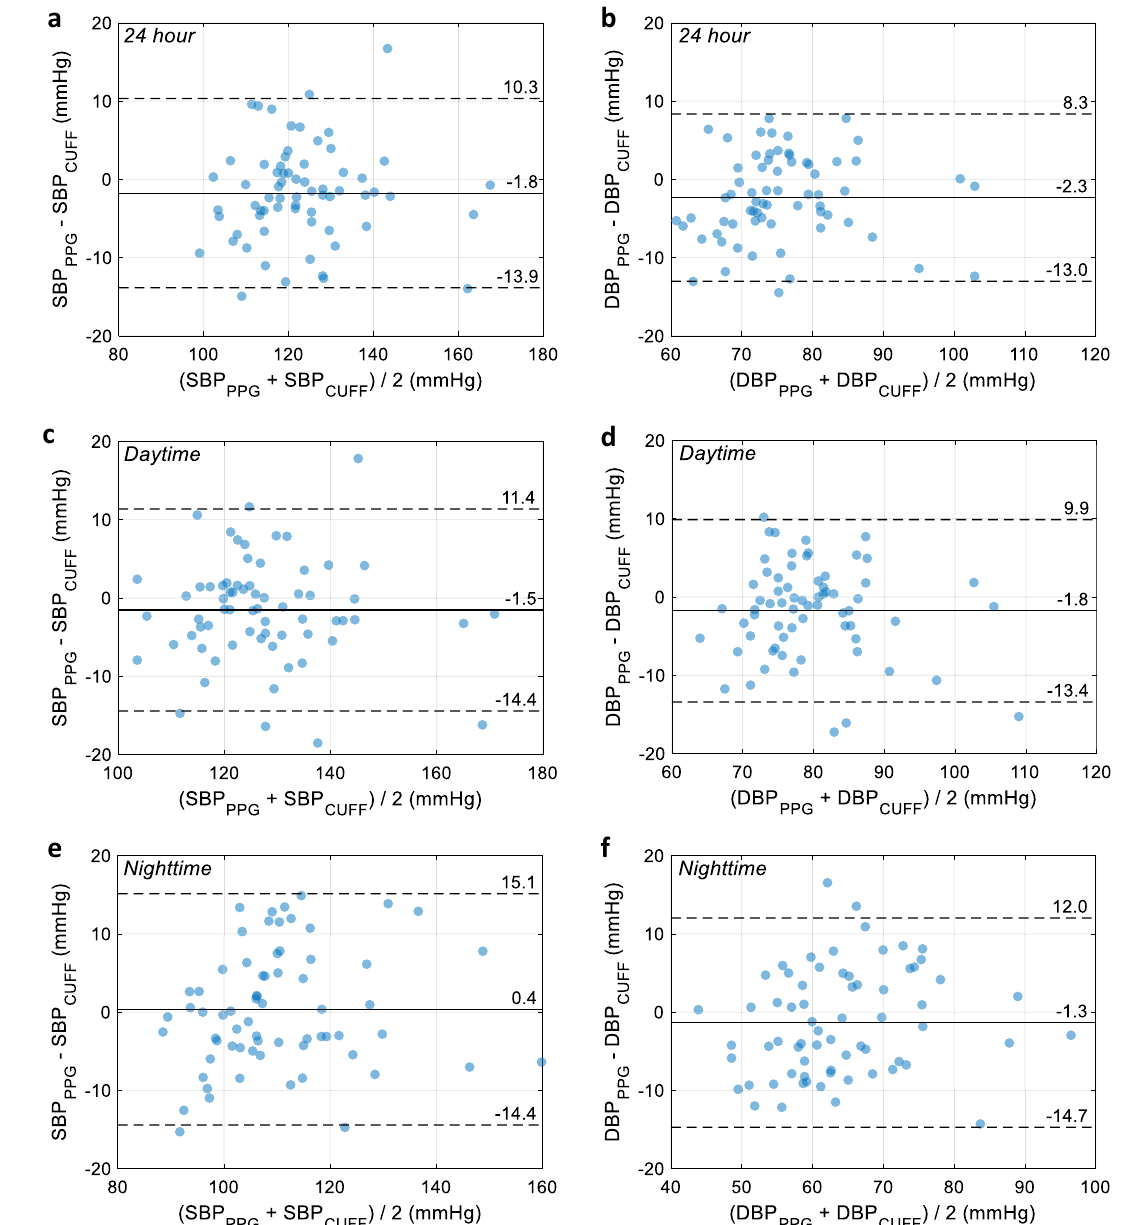
Figure 5. Bland–Altman plots comparing the PPG-derived SBP and DBP estimates to their cuff-based counterparts. ( a , b ) 24-h averages. ( c , d ) Daytime averages. ( e , f ) Nighttime averages. The solid lines depict the mean differences (biases), whereas the dashed lines depict the 95% limits of agreement. PPG photoplethysmography, SBP systolic blood pressure, DBP diastolic blood